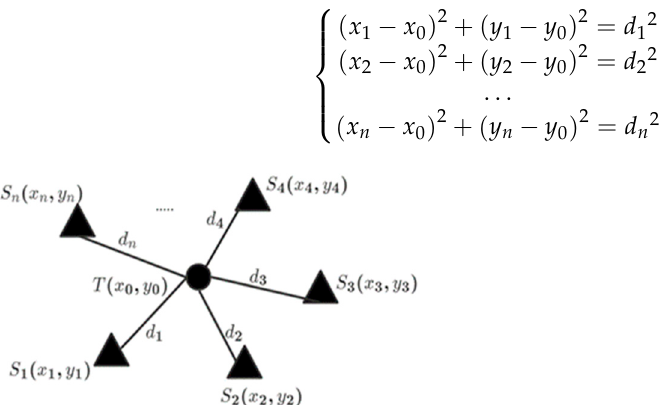
Figure 1. Principle of two-dimensional plane multilateral positioning.